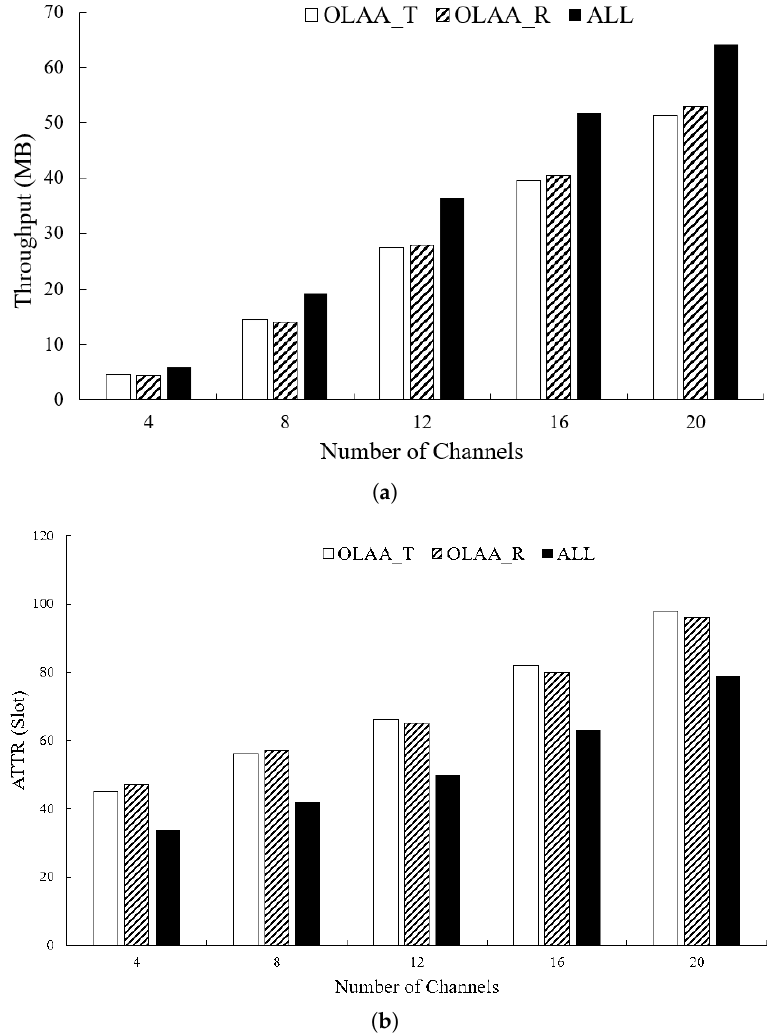
Figure 8. This figure displays the impact of the number of channels on the mesh topology’s perfor- mance in an asynchronous network, as measured by two metrics: ( a ) throughput and ( b ) ATTR.